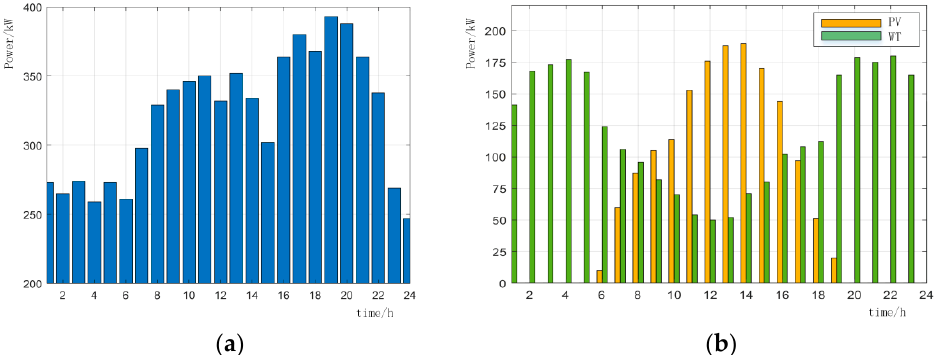
Figure 18. Load day-ahead power forecast ( a ) and renewable energy day-ahead power forecast ( b ).